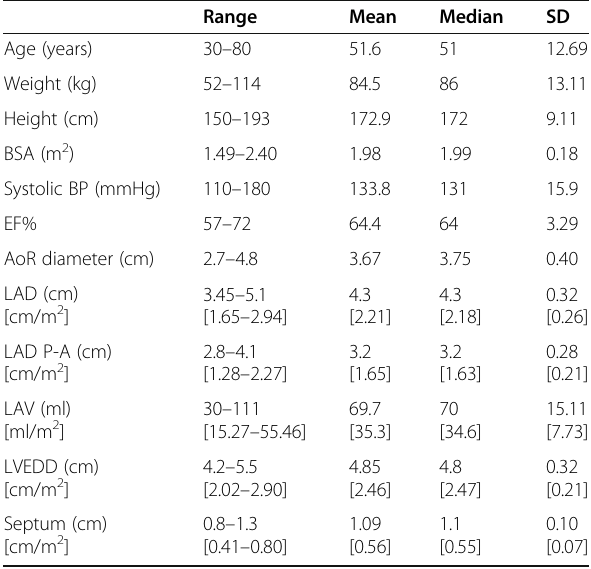
Table 1 Demographic and echocardiographic data with range, mean, median, and standard deviation